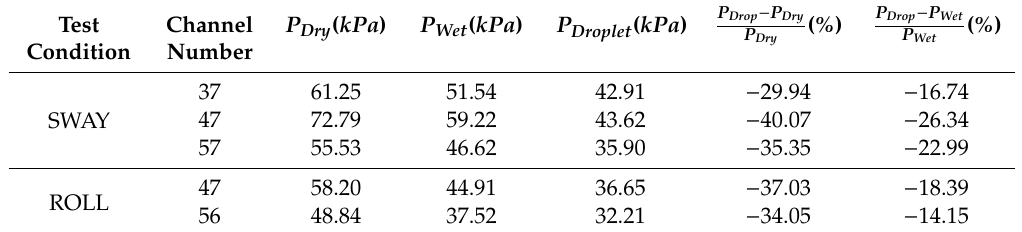
Table 8. Peak Pressure of Dry condition, Wet condition, Droplet